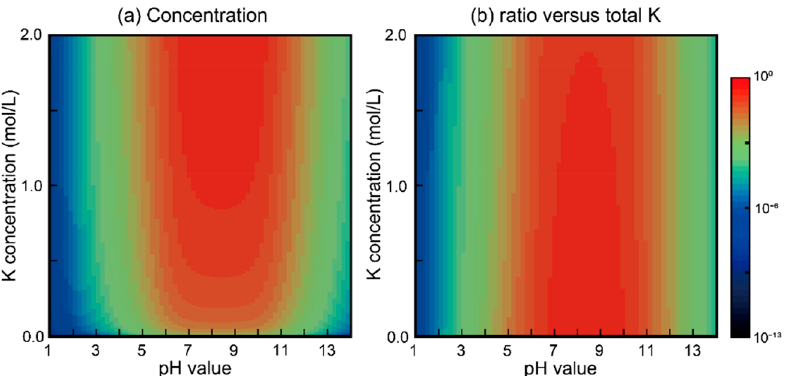
Figure 5. Calculated concentrations ( a ) and ratios ( b ) versus the total K of KHPO 4 − in a solution ◦ containing 1 mol/L PO 4 at 60 °C. containing 1 mol/L PO 4 at 60